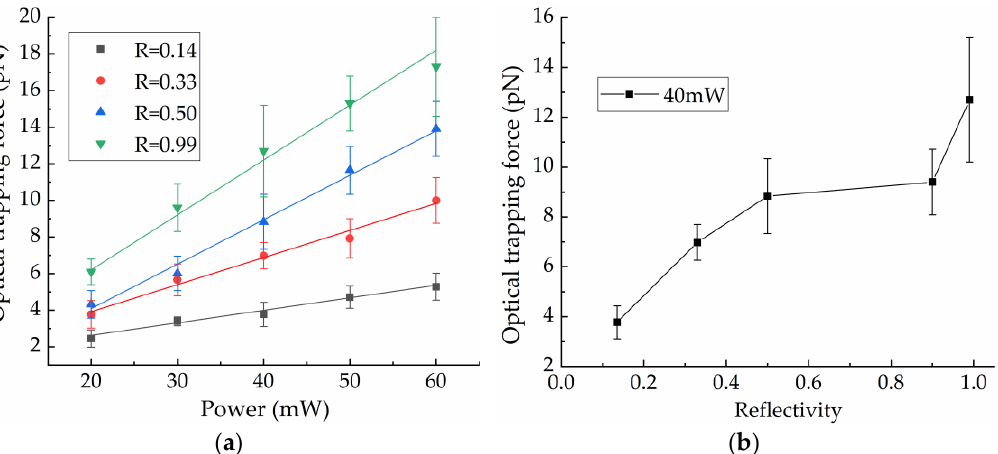
Figure 6. ( a ) The relationship between optical trapping force and laser power close to reflective films with different reflectivities; ( b ) Optical trapping force at different reflectivity when power is 40 mW. For a same laser power, the F oS increases with the reflectivity of the film. Figure 6b shows the case with a laser power of 40 mW. When the reflectivity raised from 0.14 to 0.99, F oS raised from 3.8 ± 0.7 pN to 12.7 ± 2.5 pN.